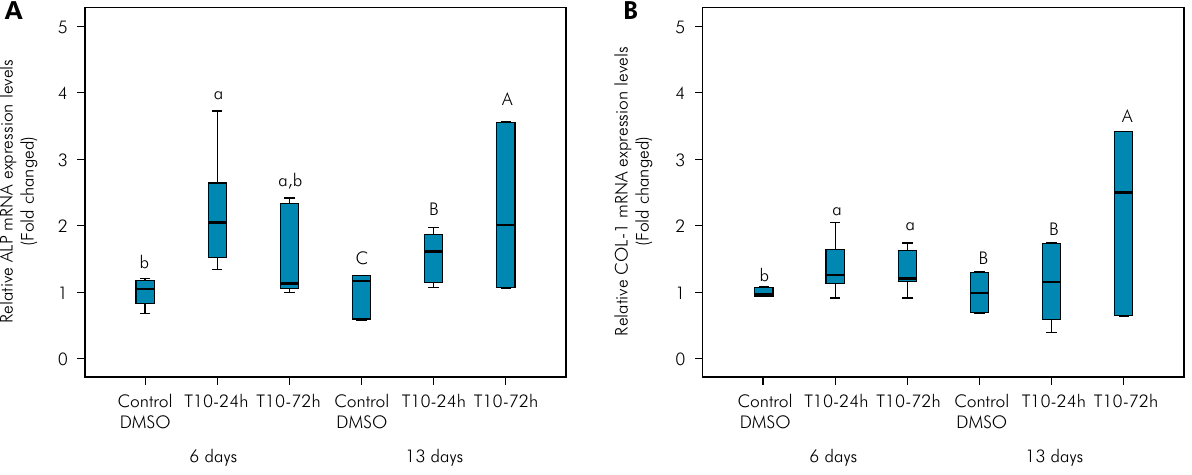
Figure 6. Expression of alkaline phosphatase - ALP (A) and collagen-1 – COL-1 (B) genes from Saos-2 cells after 6 and 13 days of treatment with